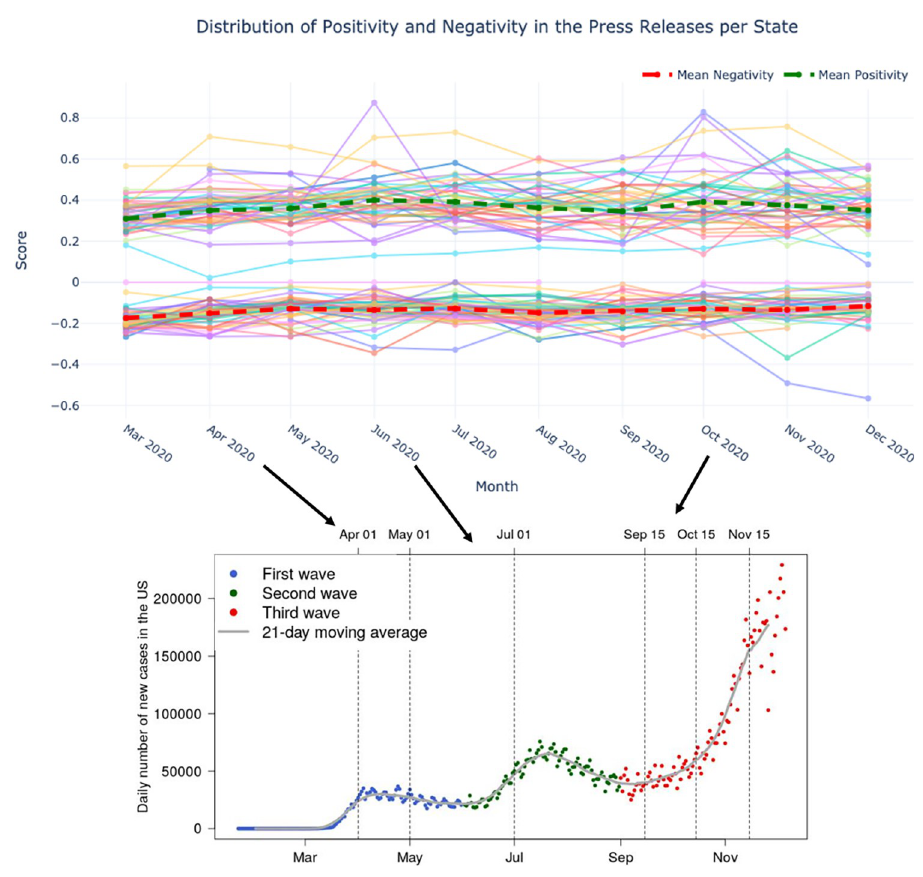
Fig 6. Positivity and negativity per state and national averages, and comparison with the COVID–19 waves.